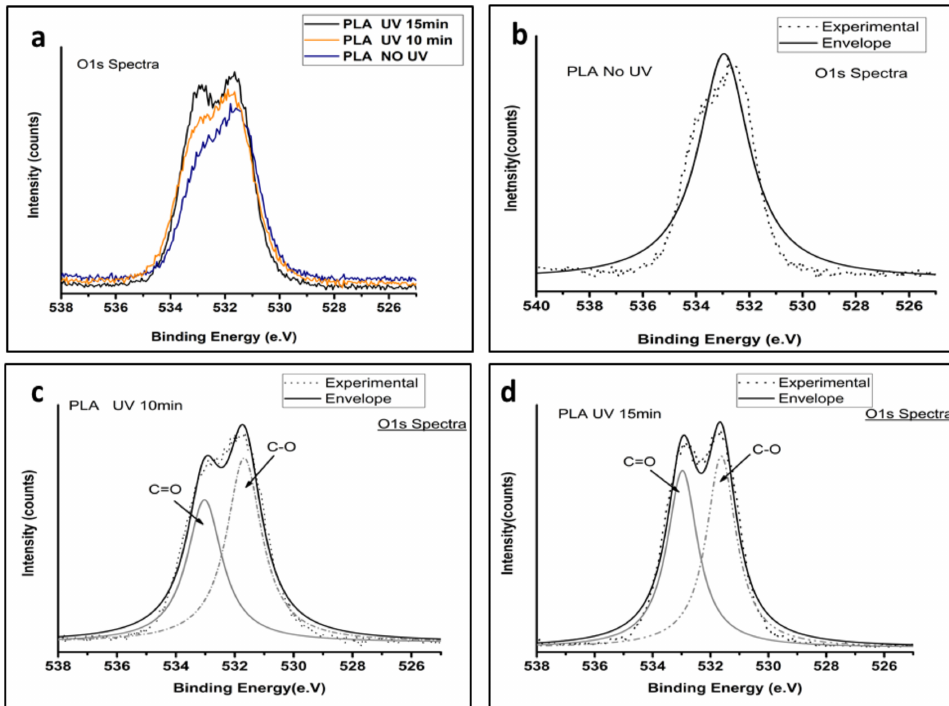
Figure 5. O1s spectra of PLA-UV: ( a ) Low-resolution spectra of irradiated BE-PLA. ( b – d ) High- resolution O1s spectra of non-irradiated PLA compared with UV 10 and 15 min treated samples. As the exposure time reached 10 and 15 min, a new peak at 533.02 ± 0.02 eV was observed with peak shouldering (Figure 5c,d) related to oxygen atoms of carbonyl groups, as shown in Figure 5b. It led to higher functional oxygen groups on the scaffold surface, which could be the main reason for enhanced surface